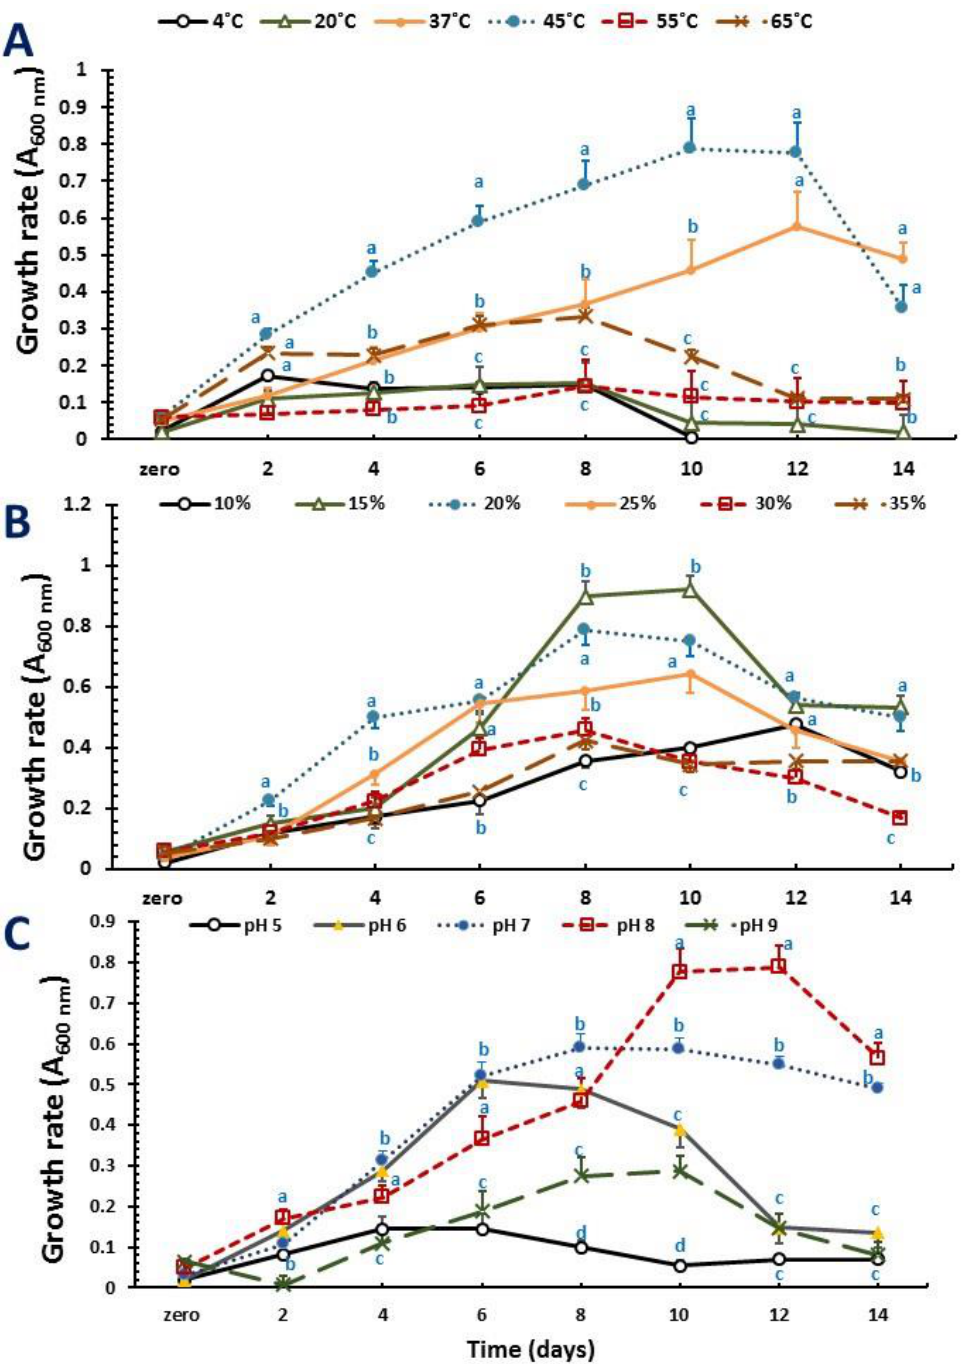
Figure 3. Effect of physical factors on the growth of PHA-producer unclassified Halolamina sp. strain NRS_38 grown. Cells were grown in a PHA-production medium supplemented with glycerol (10 g L − 1 ) as a carbon source; ( A ) temperature, ( B ) NaCl concentrations, and ( C ) pH. For each time, different superscript letters indicate significant differences at the p < 0.05 level (one-way ANOVA and Duncan post hoc test) comparing physical factors at different levels.